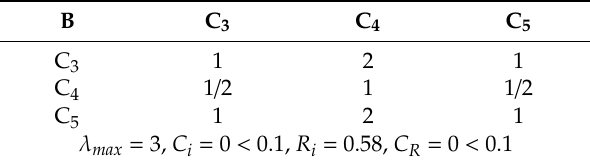
Table 11. Judgment matrix of indicator layer (layer C).